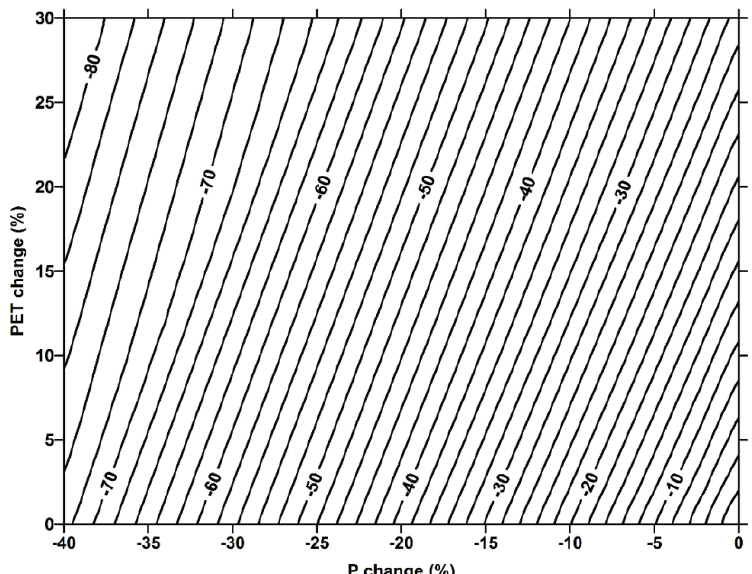
Figure 4. Foreseen runoff changes (%) of the upper Diyala example basin for an array of climatic changes for precipitation ( P ) and potential evapotranspiration ( PET